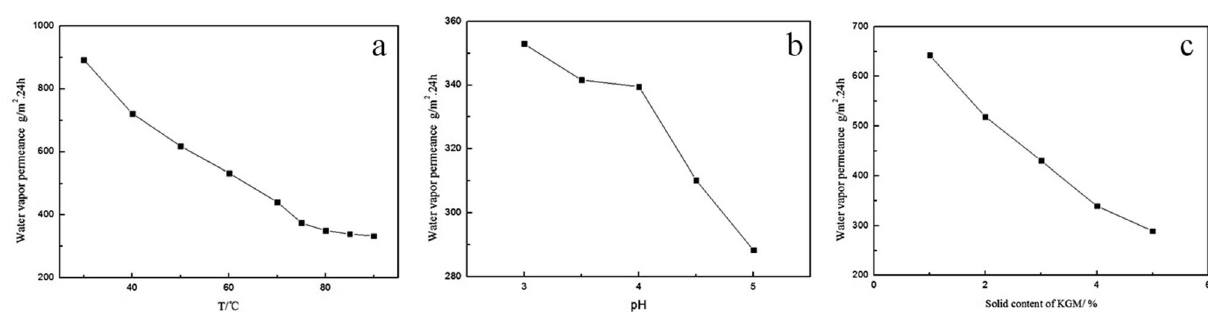
Figure 3. Influence of blending conditions on water vapor transmission. ( a ) General conditions: stirring time- 40 min; Content of KGM, CA, PVA = 4.0%, 4.0%, 5.0%; pH of glue-4.5; ( b ) general conditions: Stirring time- 40 min; T-85 ℃ ; Content of KGM, CA, PVA = 4.0%, 4.0%, 5.0% ; ( c ). General conditions: Stirring time-40 min; T-85 ℃ ;KGM:CA = 1:1; Content of PVA-5.0%; pH of